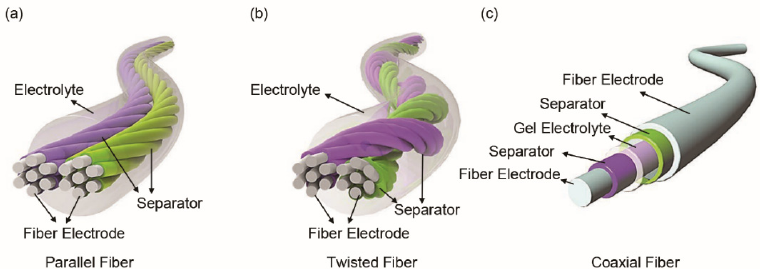
Figure 3. Assembly of fiber-shaped supercapacitors (FSSCs) with ( a ) parallel, ( b ) twisted and ( c ) coaxial structure. Reproduced with permission from ref. [45] Copyright 2019 John Wiley and Sons.